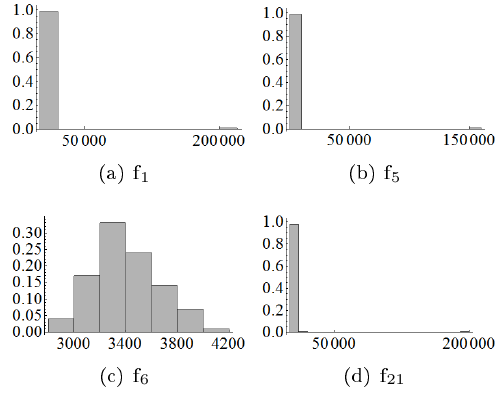
Fig. 6: The node out-strength distribution in the four aggregated networks generated on the basis of the HSDE dynamics.